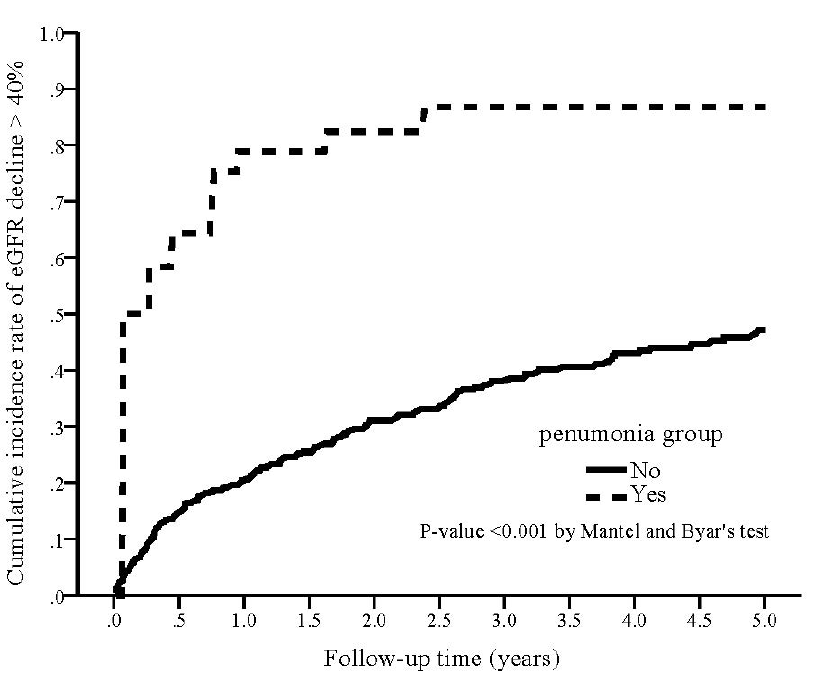
Figure 3. Kaplan–Meier curve of the cumulative incidence rate of eGFR decline > 40% for patients with and without pneumonia (Mantel and Byar’s test, p < 0.001).